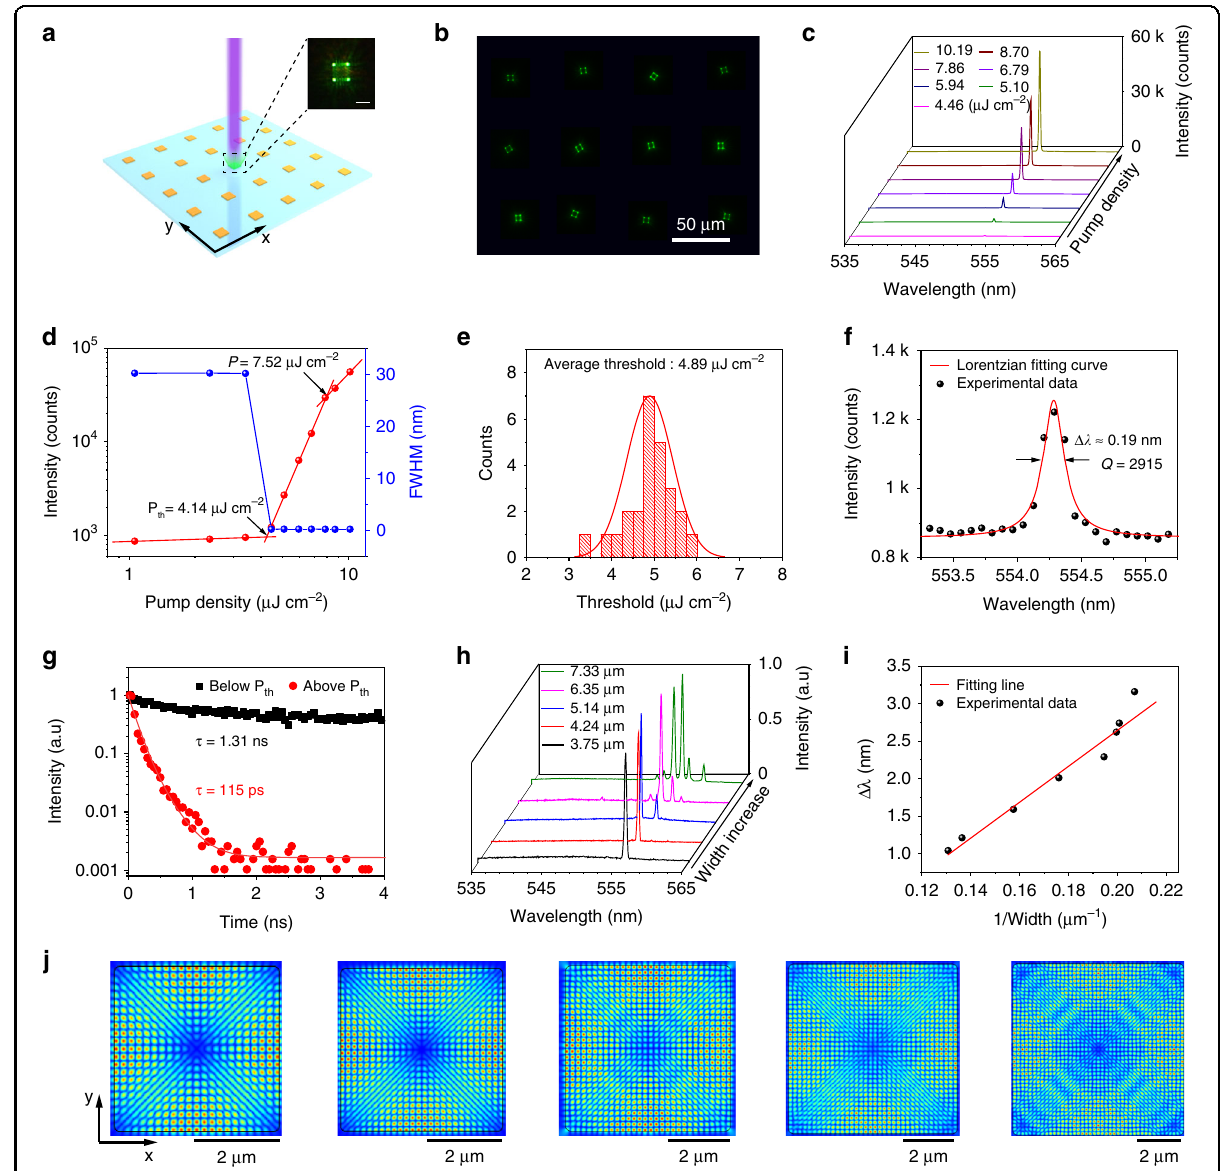
Fig. 4 Lasing performance of the MAPbBr3 MPs array. a Schematic illustration of an individual MAPbBr 3 MP excited by a 395 nm laser. The inset is a dark fi eld image of a lasing MAPbBr 3 MP. b Fluorescence microscopy image of MAPbBr 3 MPs array excited by a 395 nm laser above the lasing threshold. c PL spectra of the as-synthesized perovskite MP pumped by a 395 nm laser with different densities. d Integrated PL emission intensity (red) and FWHM (blue) of PL peaks versus the pump density. e Statistics of the lasing threshold of MAPbBr 3 MPs array. f Lorentzian fi tting result of a lasing peak. g PL decay curves of the MAPbBr 3 MPs obtained below and above the P th . h PL spectra of MAPbBr 3 MPs with fi ve different widths. i Δλ as a function of the MAPbBr 3 MP width. j FDTD simulation of the two-dimensional electric fi eld distribution inside the MAPbBr 3 MPs labeled in ( h